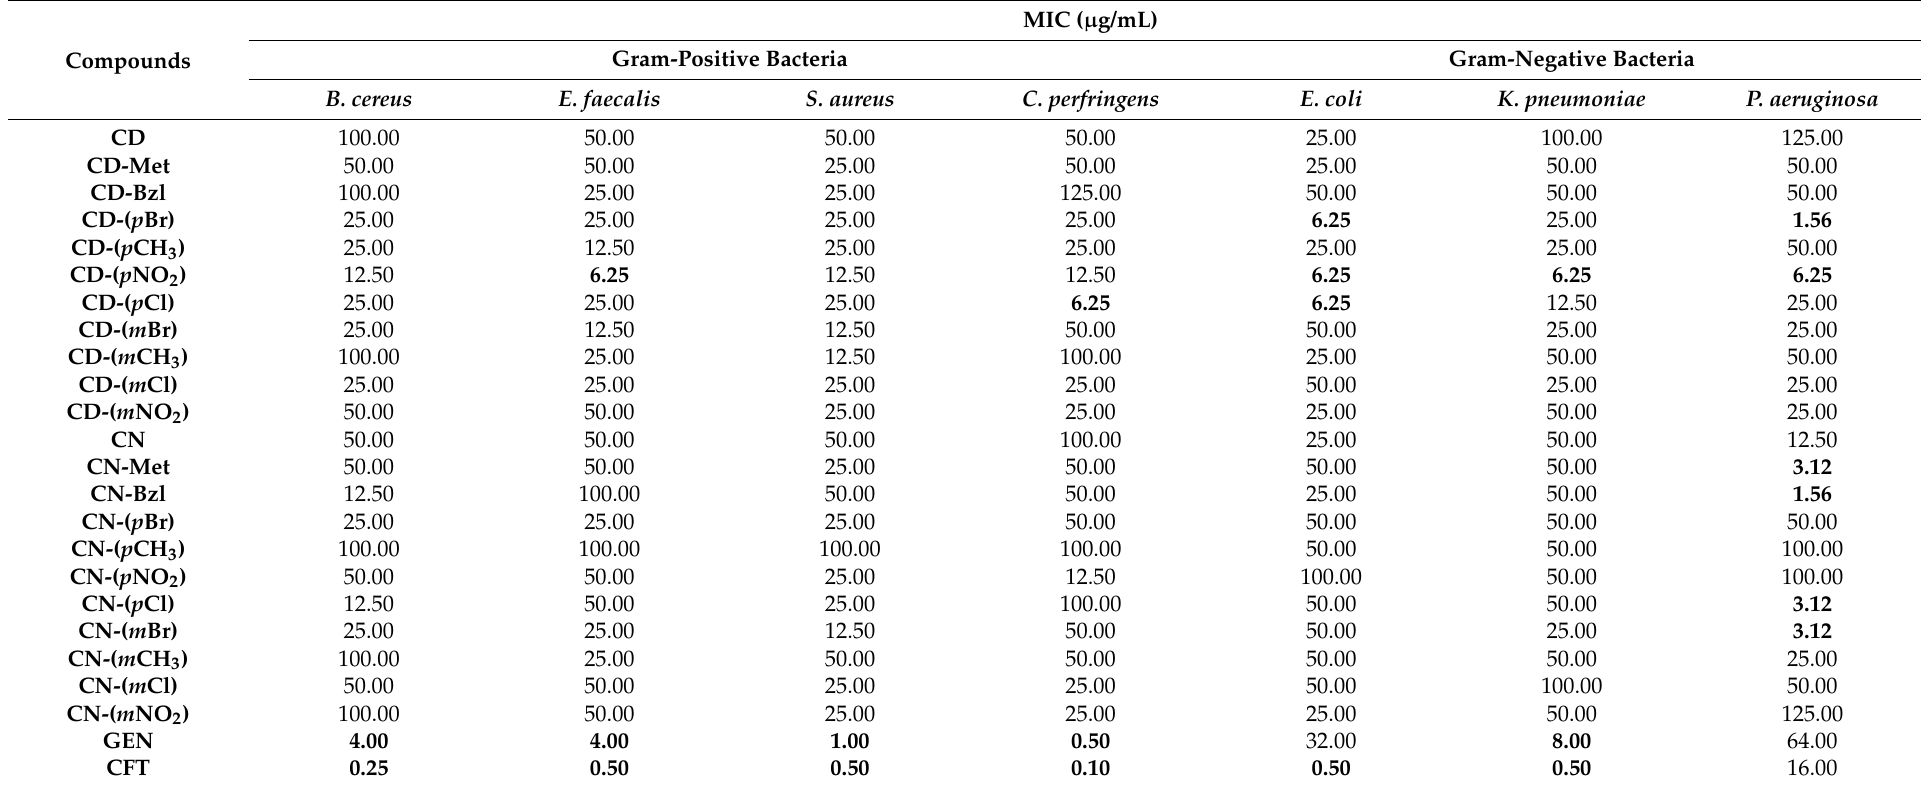
Table 2. Determined MIC values for CD and CN quaternary derivatives, gentamicin (GEN) and cefotaxime (CFT) against a panel of Gram-positive and Gram-negative bacterial strains. No bioactivity was defined as a MIC > 1000 µ g/mL, mild bioactivity as a MIC in the range 512–1000 µ g/ mL, moderate bioactivity as a MIC in the range 128–512 µ g/mL, good bioactivity as a MIC in the range 32–128 µ g/mL, strong bioactivity as a MIC in the range 10–32 µ g/mL, and very strong bioactivity as a MIC < 10 µ